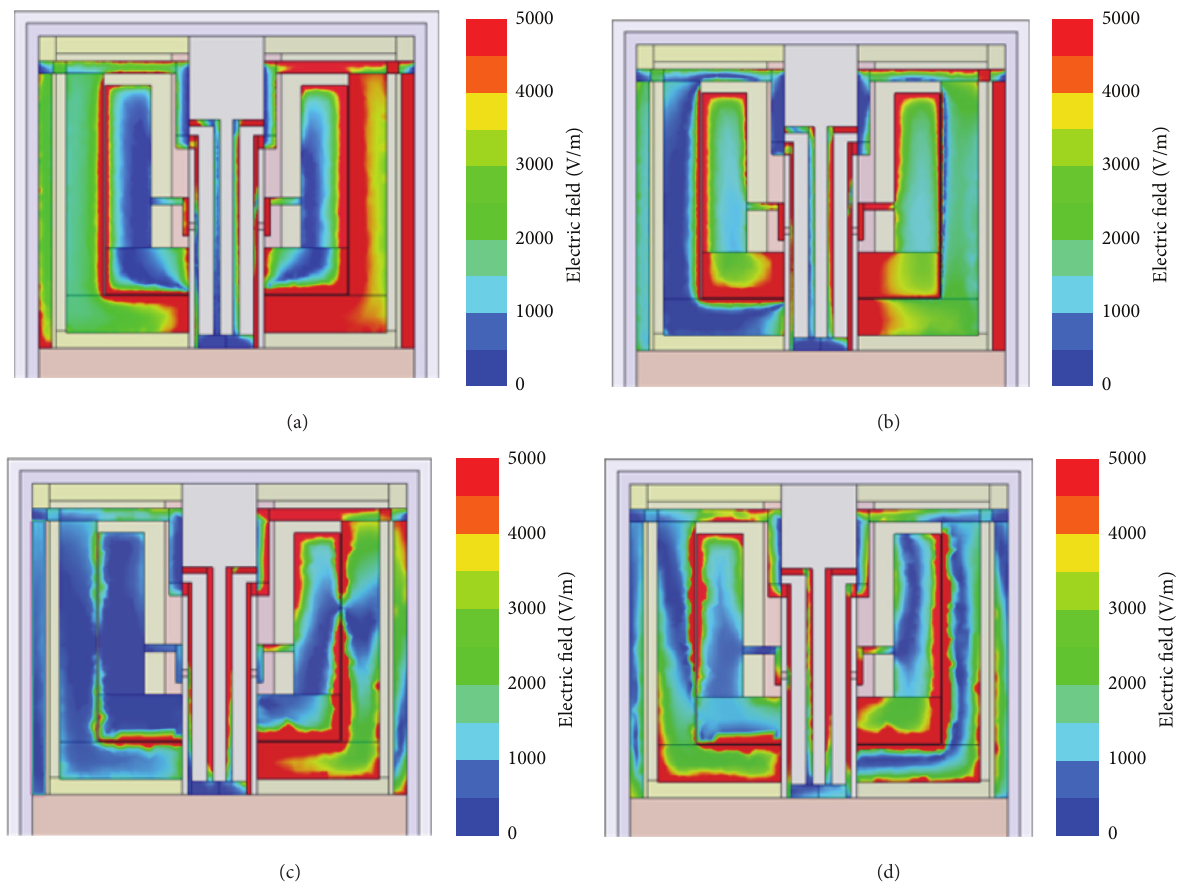
Figure 4: Simulated surface electric field distributions of proposed antenna: (a) 790 MHz, (b) 960MHz, (c) 2500 MHz, and (d) 2690